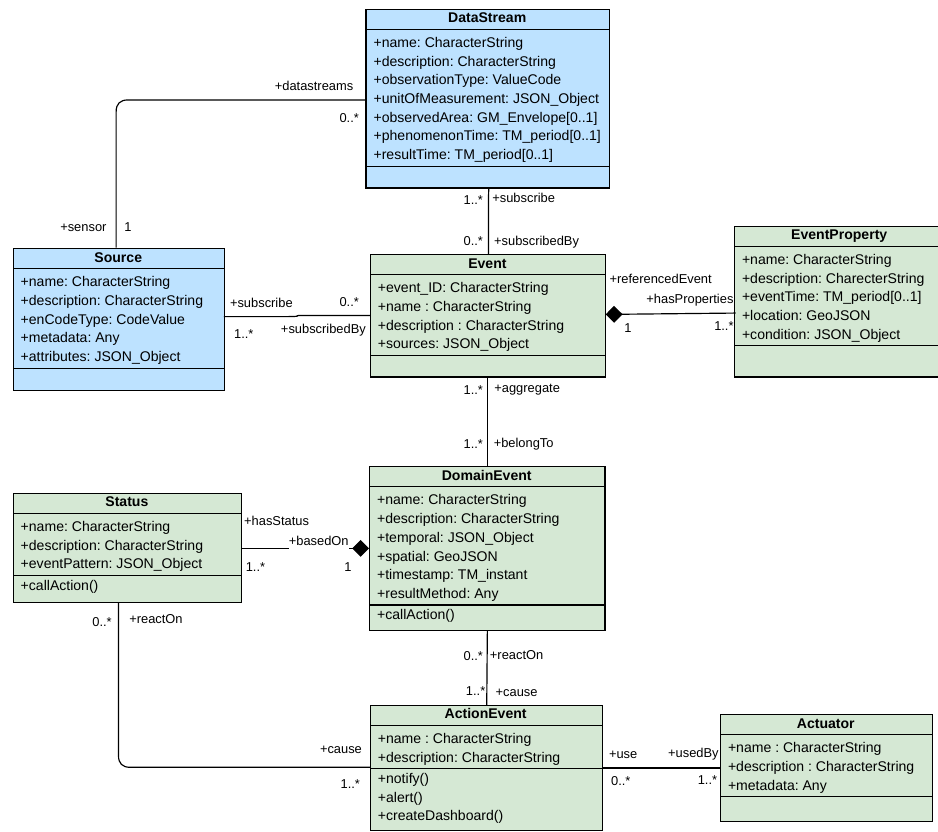
Figure 3. The meta classes of Event-driven City Data Model (ECDM) for smart city and their